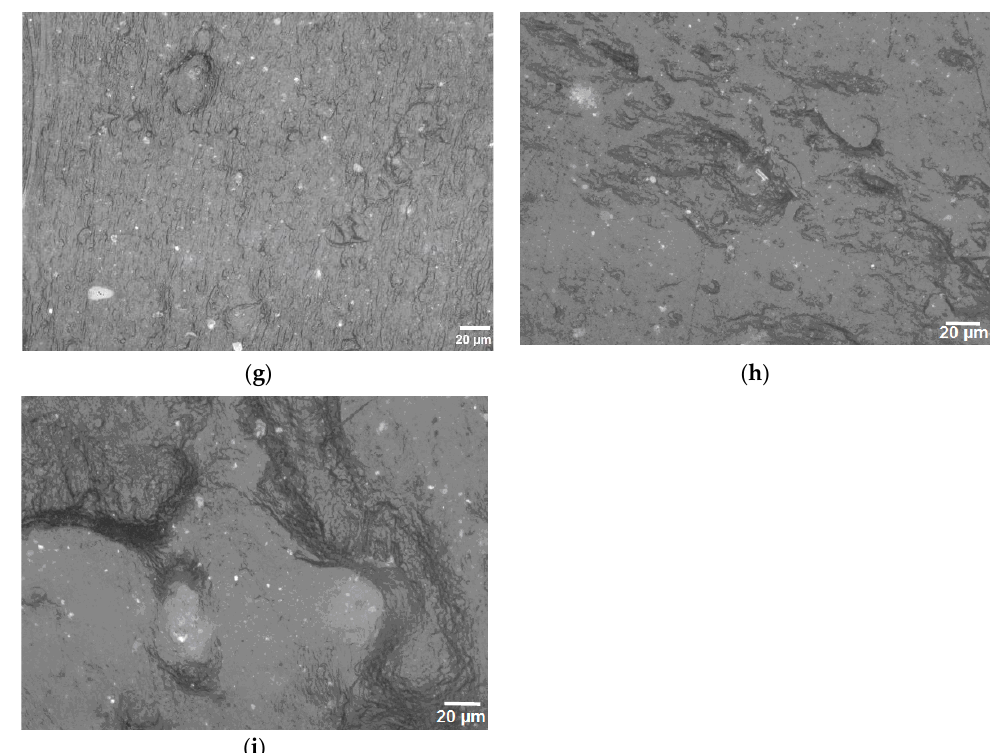
Figure 5. Optical images (500×) for: PPW ( a ); PPW/SBSBC ( b ); PPW/n-Clay 5% ( c ); PPW/n-Clay 10% ( d ); PPW/SBSBC/n-Clay 5% ( e ); PPW/SBSBC/n-Clay 10% ( f ); PPW/SISBC ( g ); PPW/SISBC/n-Clay 5% ( h ); PPW/SISBC/n-Clay 10% ( i ).